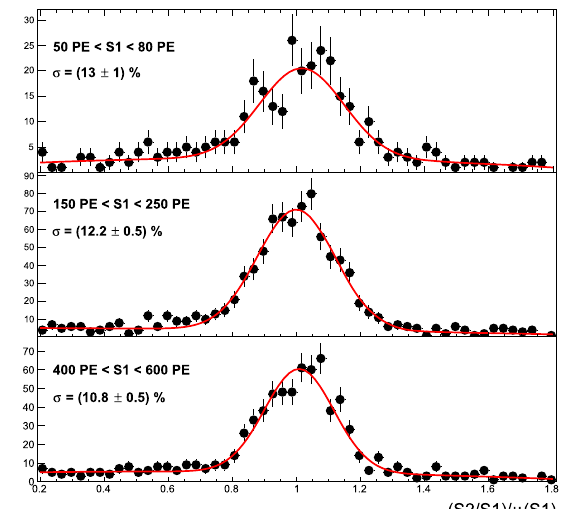
Fig. 15 Left: Distribution of NRs (blue points, f prompt > 0 . 4) com- pared to all events (red points) in the S2/S1 vs. S1 plane for the AmBe + DD combined dataset. The most probable values of S2/S1 as a function of energy, μ( S 1 ) , are represented by the black curve and